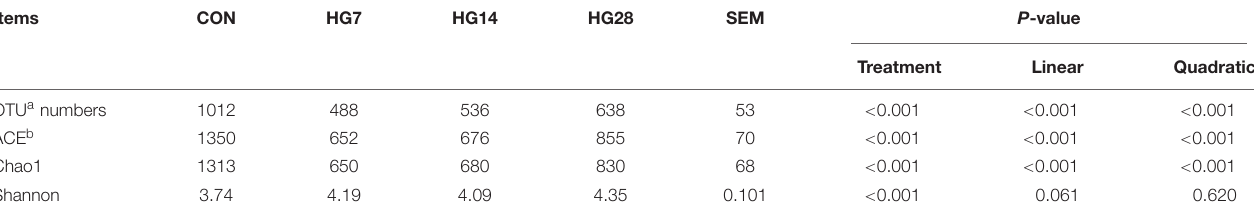
TABLE 2 | Effects of feeding a high-grain (HG) diet on the average richness and diversity of colonic mucosa-associated bacteria community at the 3% dissimilarity level. Items CON HG7 HG14 HG28 SEM P -value Treatment Linear Quadratic